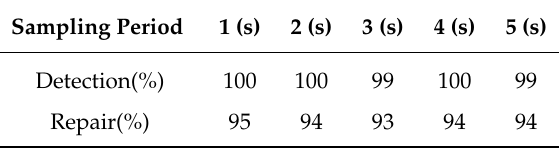
Table 6. The results of detected and corrected of the cycle slips in case